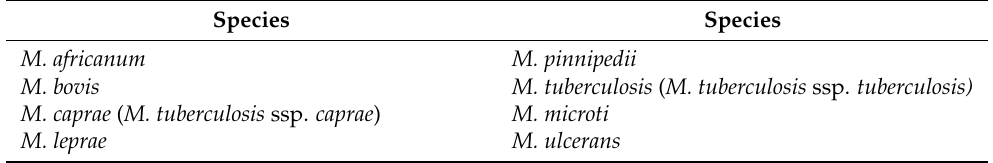
Table 6. Mycobacteria in Risk Group 3 according to European Union Directive 2000/54/EC [187].